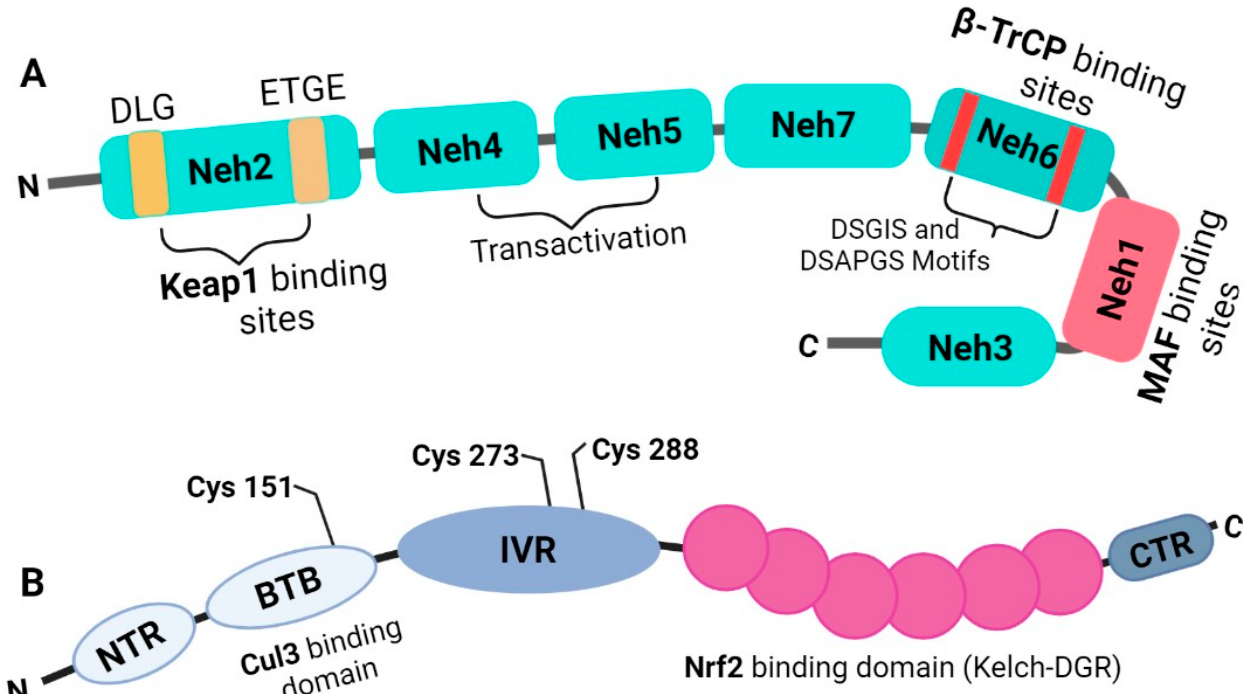
Figure 1 . Illustration for Nrf2 and Keap1 Structures: ( A ) Nrf2 is a 589-amino acid long amino acid protein containing seven domains specific for different functions. At C terminal, Neh1 is located between Neh6 and Neh3 domains and has Maf as DNA binding sites. Neh6 has serine-rich DSGIS and DSAPGS motifs, which are degron involved in mediating Nrf2 nuclear degradation. Neh2 domain is located at the N-terminal region that provides the binding sites for Keap1. Similarly, in ( B ) cartoon of Keap1 is illustrated. Kelch-DGR is an Nrf2 binding domain located at the C-terminal region, while Cullin 3 binding domain (BTB) is situated at the N terminal of the protein.